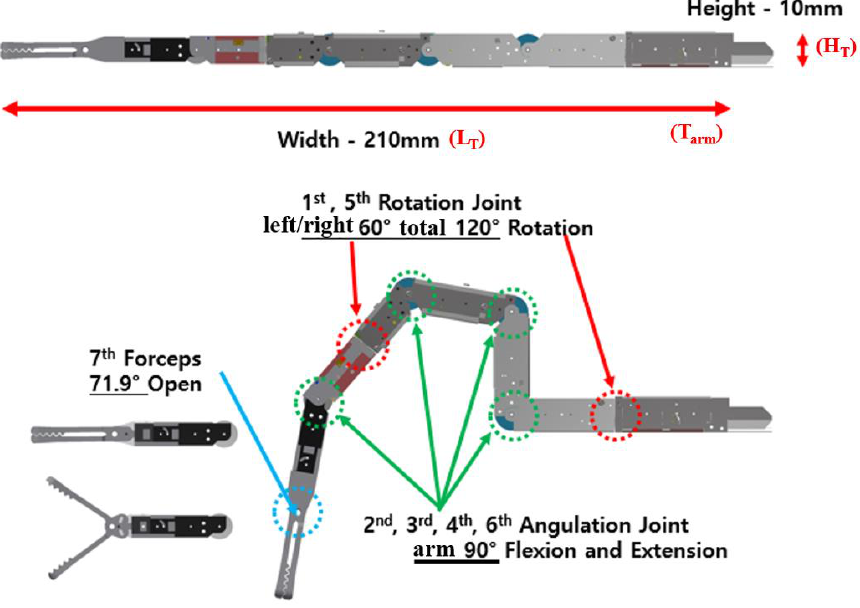
Figure 1. 7-DOF wire-driven surgical robot arm.